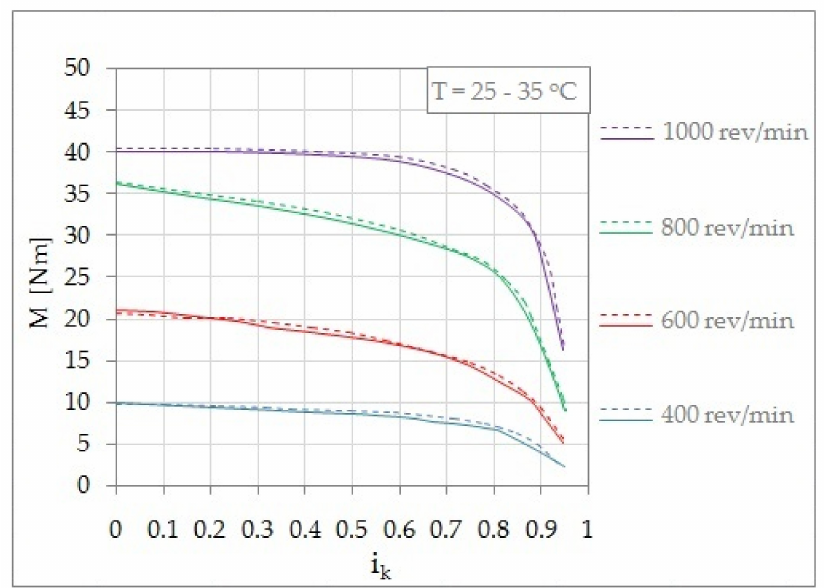
Figure 9. The steady-state characteristics of the hydrodynamic clutch (type KG VTK274T) for the tested working fluids. — = blackcurrant seed oil and - - - = hydraulic